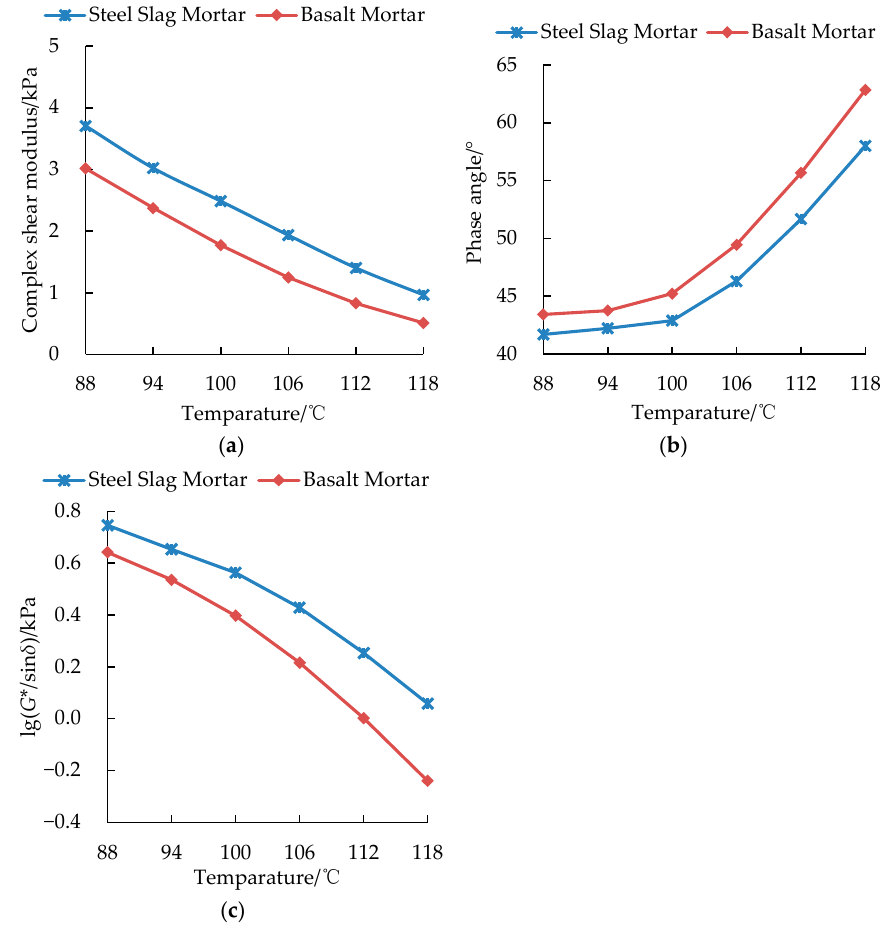
Figure 2. High-temperature rheological property results: ( a ) Complex shear modulus; ( b ) Phase angle; ( c ) Rutting resistance parameter.